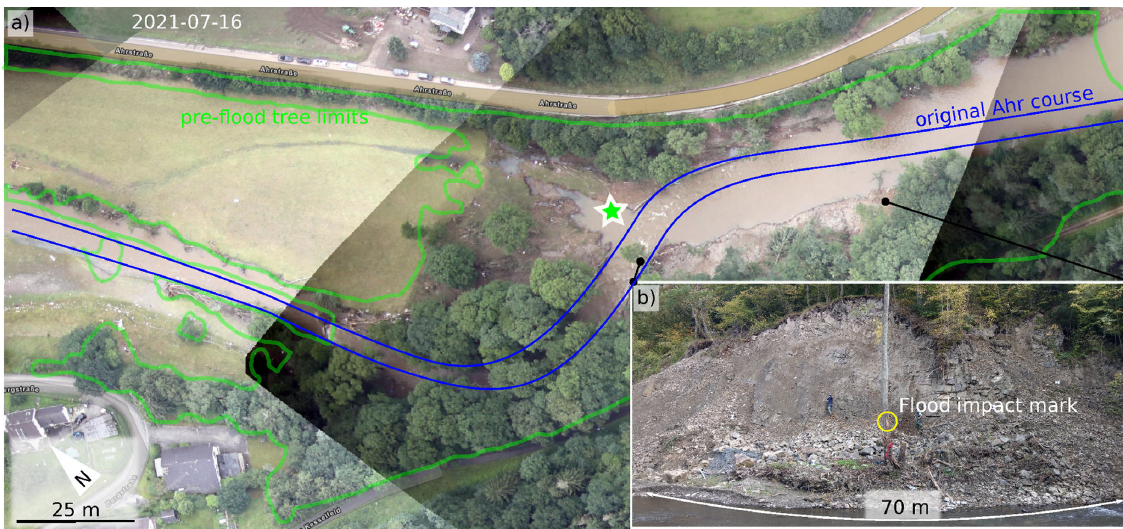
Figure 4. Debris mobilisation features in the Ahr valley near Müsch (cf. Fig. 1). Aerial image (BBK-DLR, 2022) taken 1d after the flood. The light-green outline depicts the tree limit before the flood. Blues lines illustrate the pre-flood course of the Ahr River. (b) View from the green star in panel (a) towards the eroded right bank, which had activated a 16m high rockslide (persons for scale). Note flood impact mark on a remaining tree at 5m above current water level. Please note that the date format used in this figure is